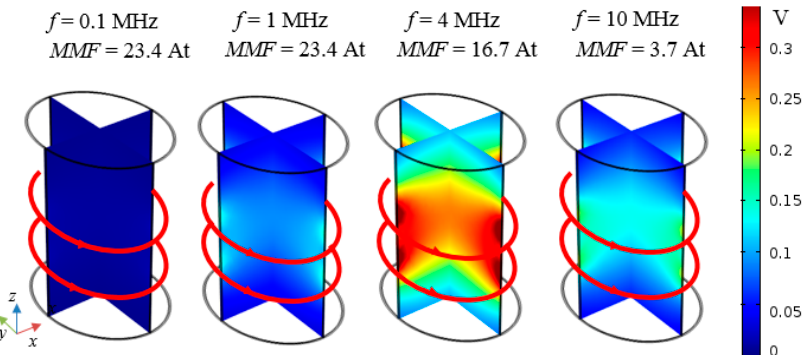
Figure 5. Maps of V max in a small loop ( S = 1 cm 2 ) inside the simplified model of a human torso at different frequencies.